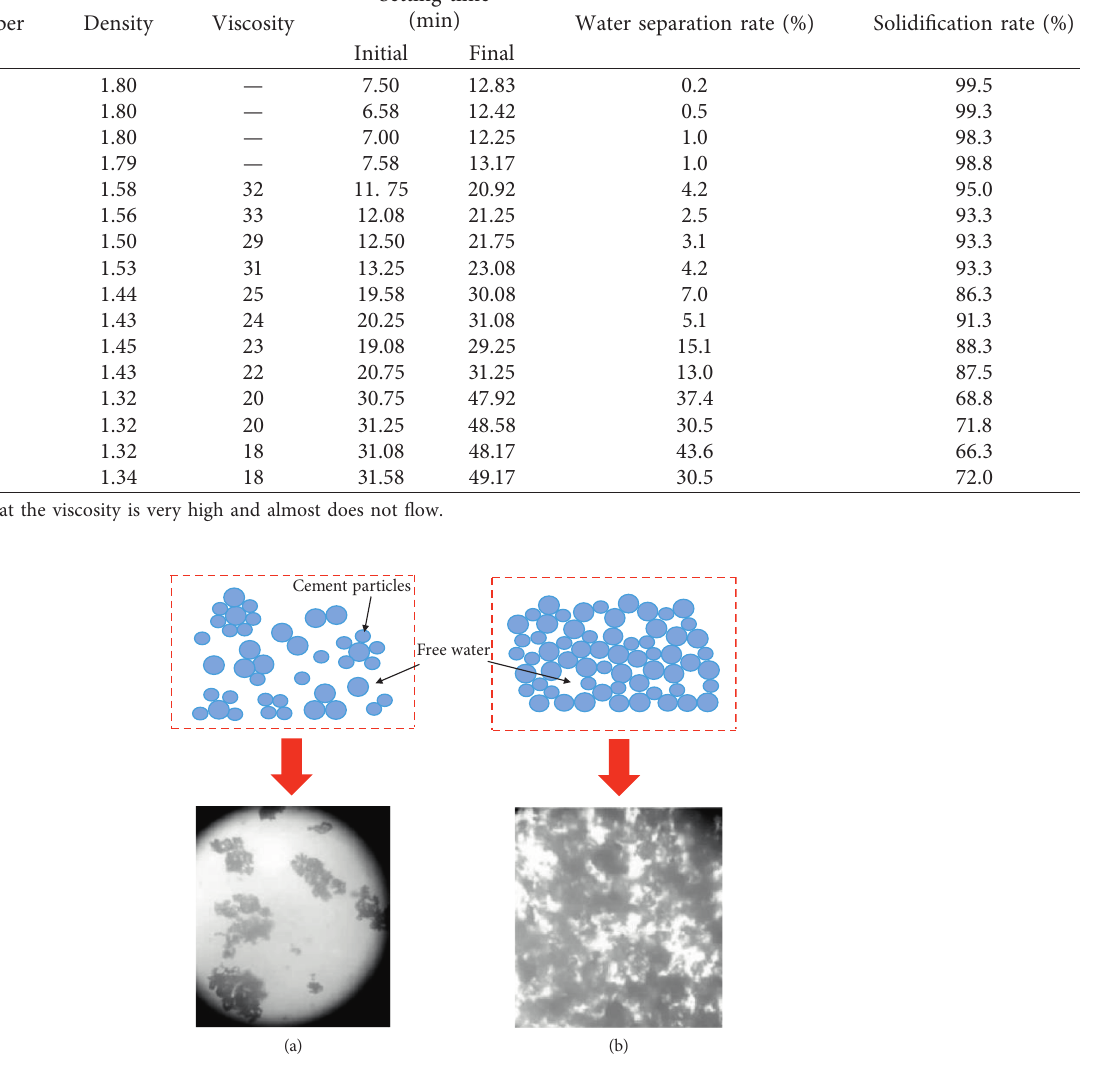
Figure 1: Flocculation structure diagram of cement slurries with different water-solid ratios [29]: (a) high water-solid ratio slurry and (b) low water-solid ratio